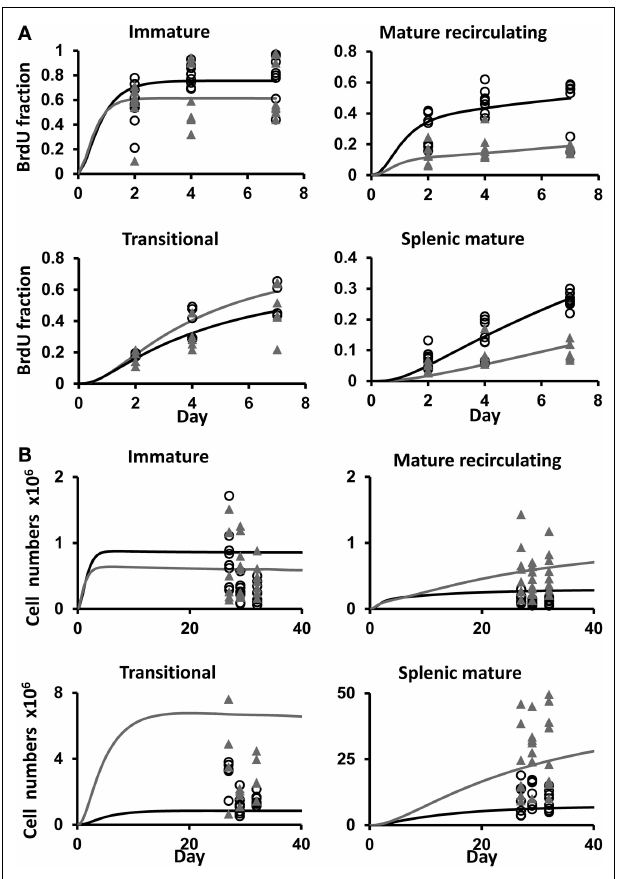
FIGURE 4 | (A) BrdU labeling kinetics obtained by a simulation of the B cell development model using the parameter value set that gave the best fit to the data, shown (as lines) along with the data (symbols), for control (filled gray triangles and gray lines), and depleted mice (open black circles and black lines), in the immature, mature recirculating, transitional, and splenic mature B cell subsets. The x -axis shows the time from the start of labeling. (B) The ranges of total cell numbers in each B cell subset in the experimental measurements of control and depleted mice and the corresponding simulations [symbols and lines are as in (A) ]. The x -axis shows the time from the start of B cell depletion. The parameter values used in these simulations are given in Table 1